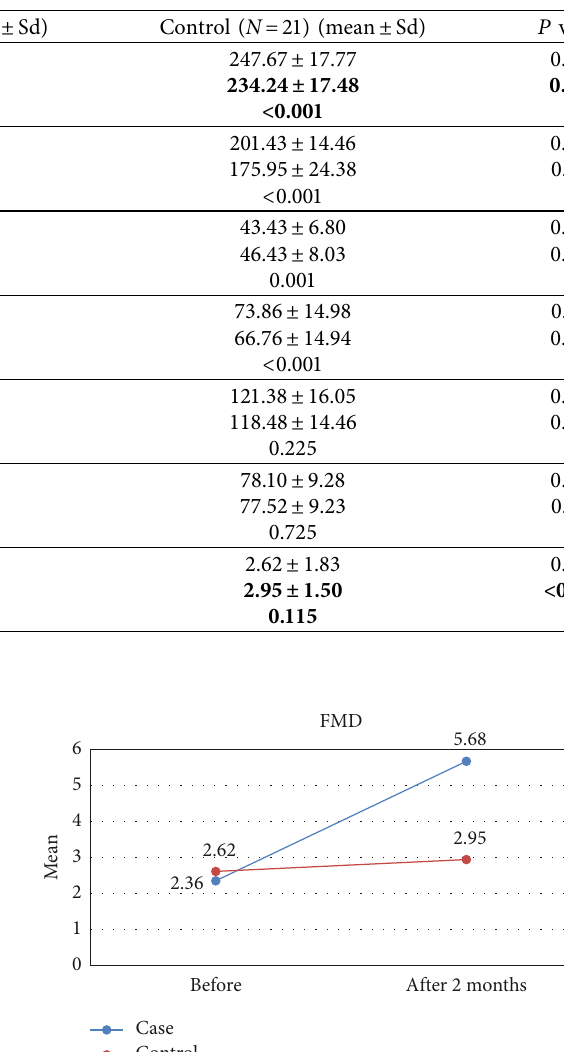
Table 1: Summary of the results.